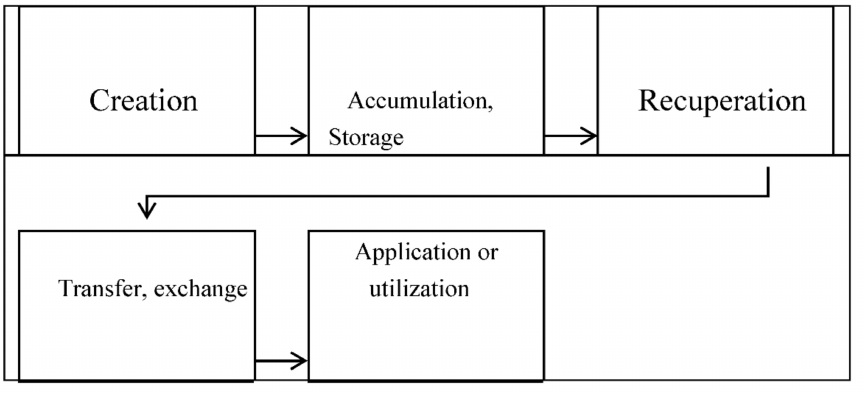
Figure 2. Knowledge management process (KMP). Source: own elaboration, adaptation of the proposal of [13].